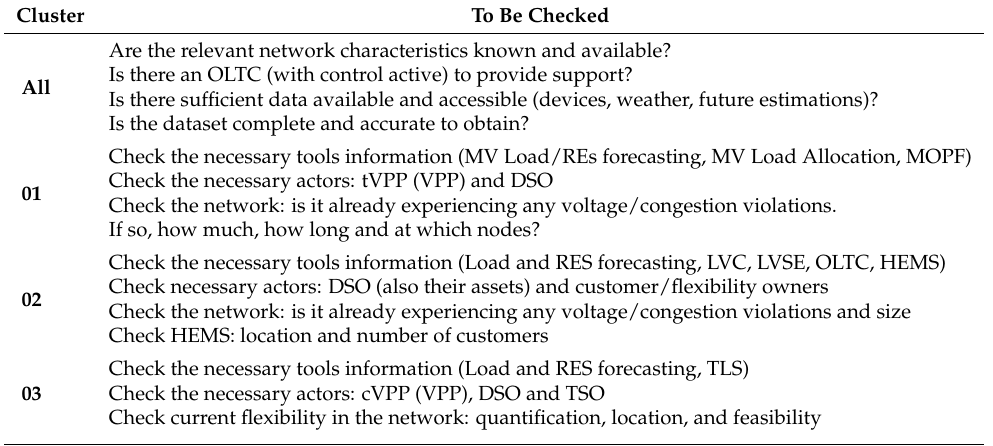
Table 14. Functional-oriented compressed